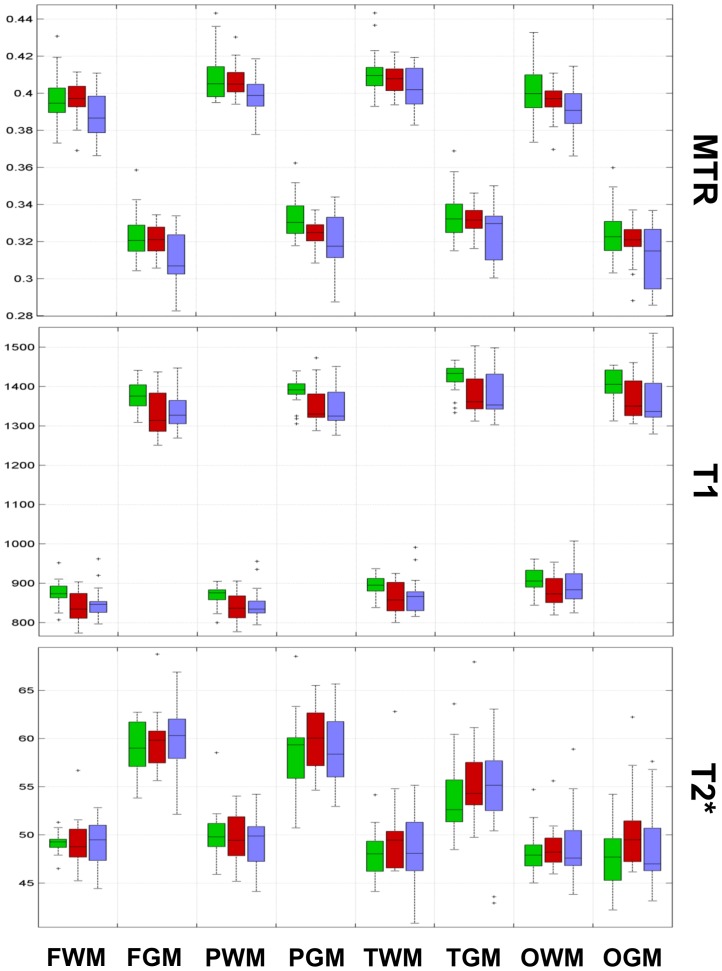
Boxplots representing data from the univariate analysis for lobar WM and cGM.In each box, the central mark represents the median, the edges represent the 25th and 75th percentiles and the whiskers extend to the most extreme data points not considered outliers; outliers are plotted individually as x. HC: green; MND−: red; MND+: blue. FWM: frontal WM; PWM: parietal WM; TWM: temporal WM; OWM: occipital WM; FcGM: frontal cGM; PcGM: parietal cGM; TcGM: temporal cGM; OcGM: occipital cGM.